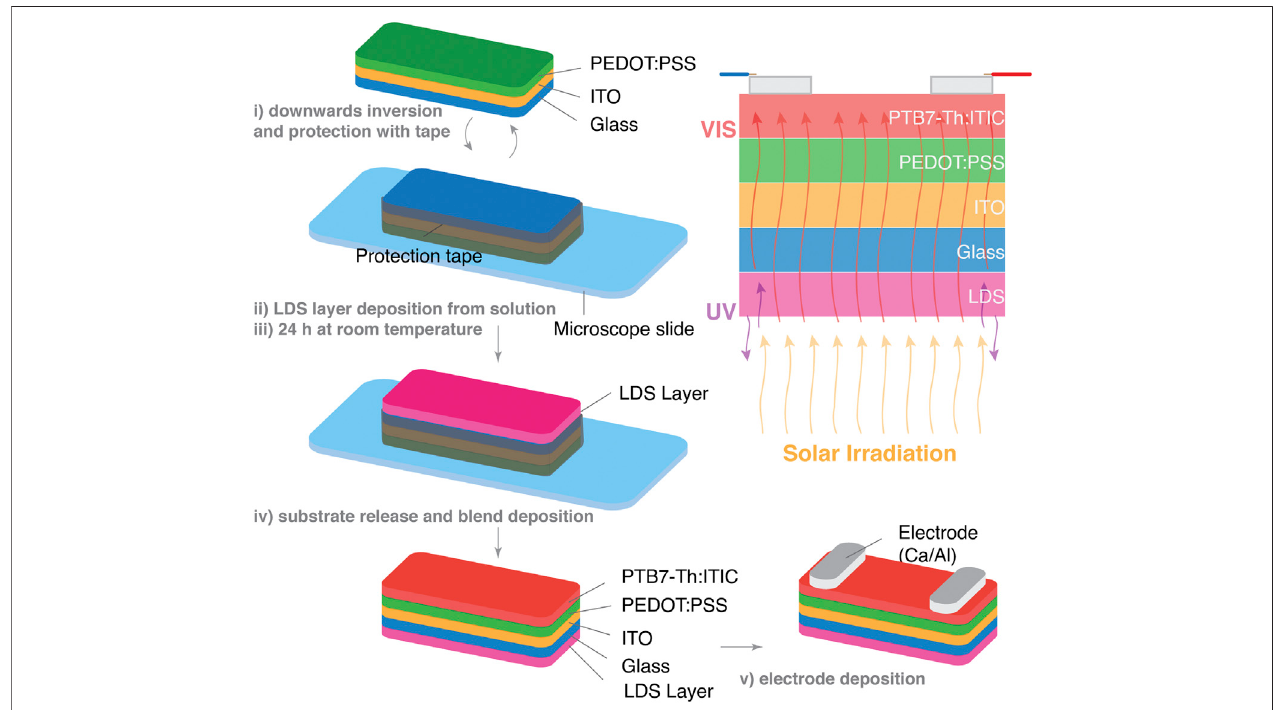
FIGURE2| Outlineofthefabrication stepsofthedU6EuLDS-coatedOPVdevicesinthisstudyanddepictionoftheUV- fi lteringandlightdownshiftingphenomena taking place in the LDS layer.